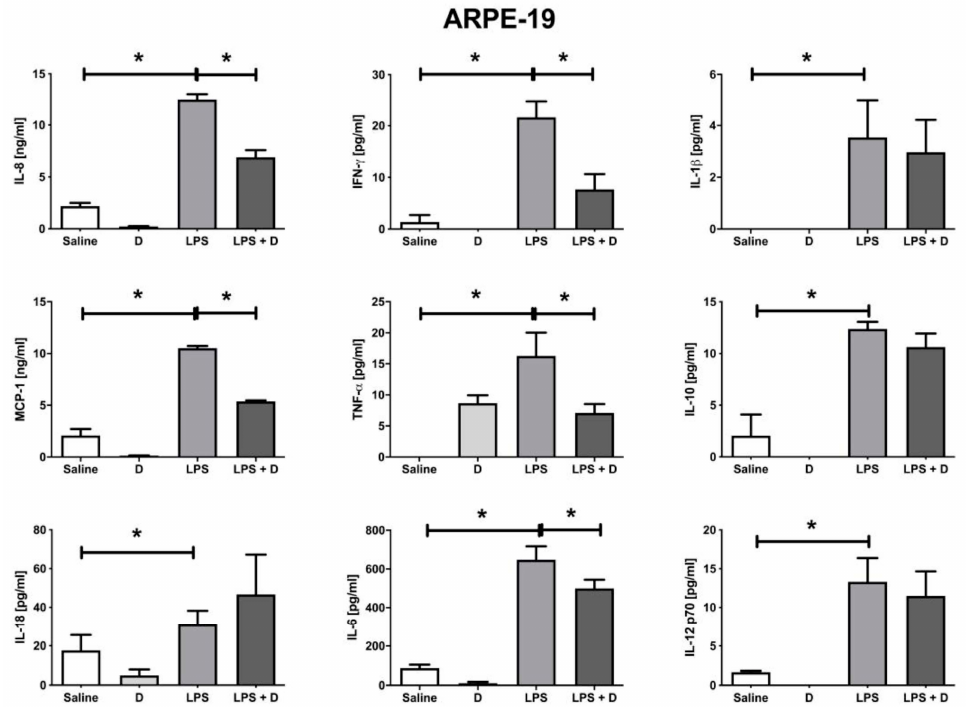
Figure 7. Multiplex inflammatory cytokine array in ARPE-19 cells. All inflammatory cytokine levels were increased by adding LPS (* p < 0.05), and Interleukin (IL)-8, Interferon (IFN)- γ , Monocyte chemoattractant protein (MCP)-1, Tumor necrosis factor (TNF)- α , and IL-6 levels were reduced (* p < 0.05) with the addition of VITD in concomitance. n = 3.